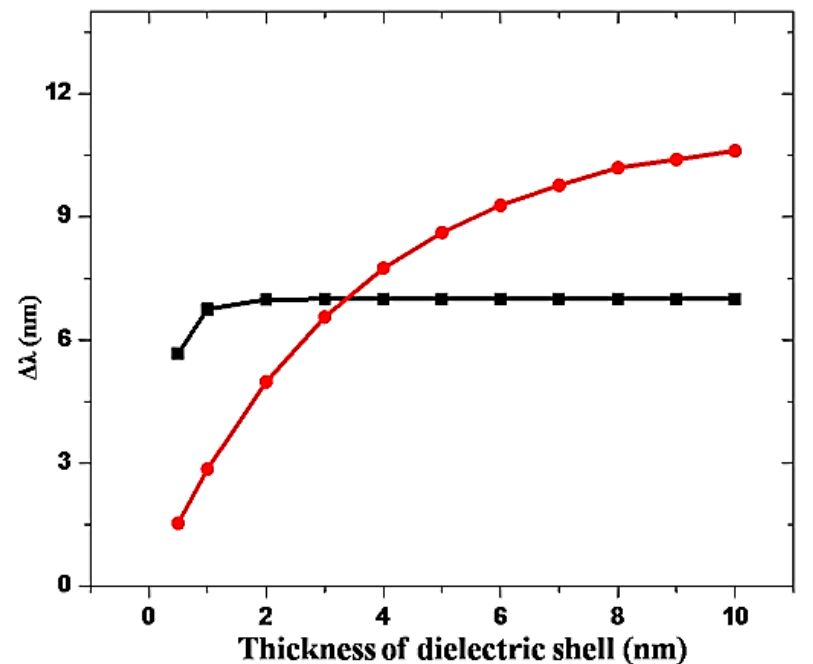
Figure 6. LSPR spectral shift of gold nanospheres of radii 2.5 nm (black square) and 25 nm (red circle) with dielectric shells of varying thickness.